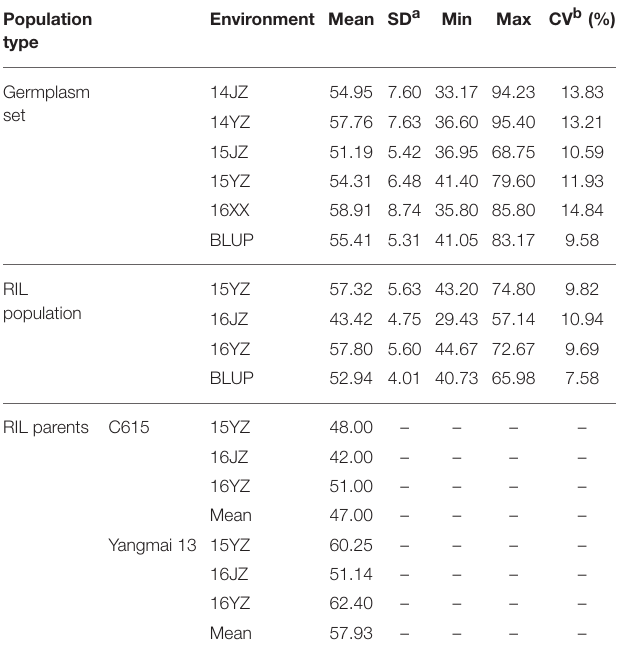
TABLE 1 | Descriptive statistics for kernel number per spike in the two populations assessed in this study. Population